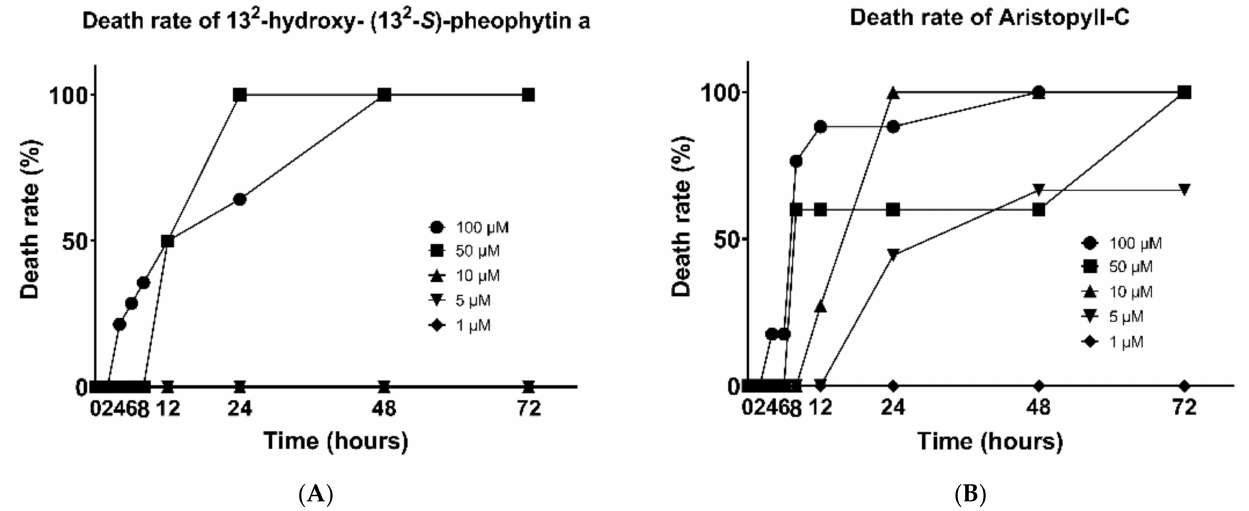
Figure 2. Cestocidal activity on H. nana of 13 2 -hydroxy-(13 2 -S)-pheophytin a ( A ) and aristophyll-C ( B ). Treatment with 1, 5, 10, 50, and 100 µ M, with incubation times of 2, 4, 6, 8, 12, 24, 48, and 72